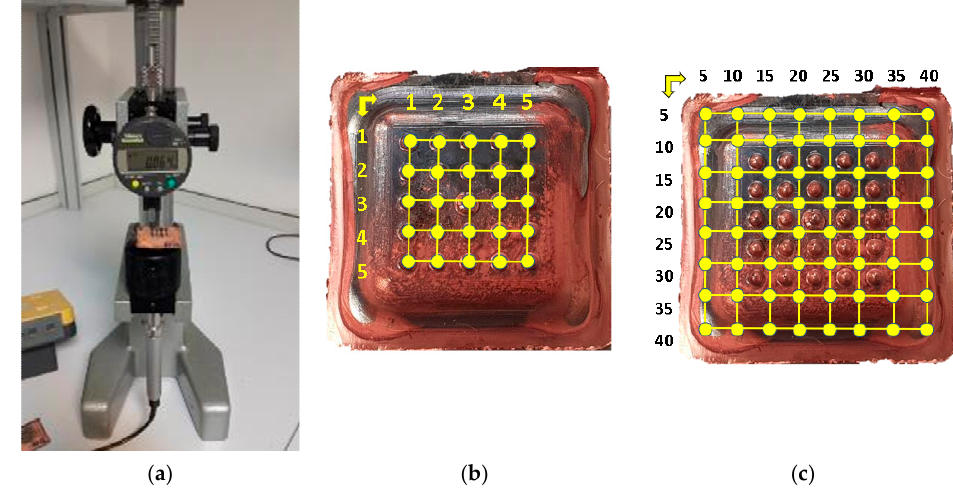
Figure 11. ( a ) Measurement process. ( b ) Cavities measurement points. ( c ) Coordinates of surface measurement points.